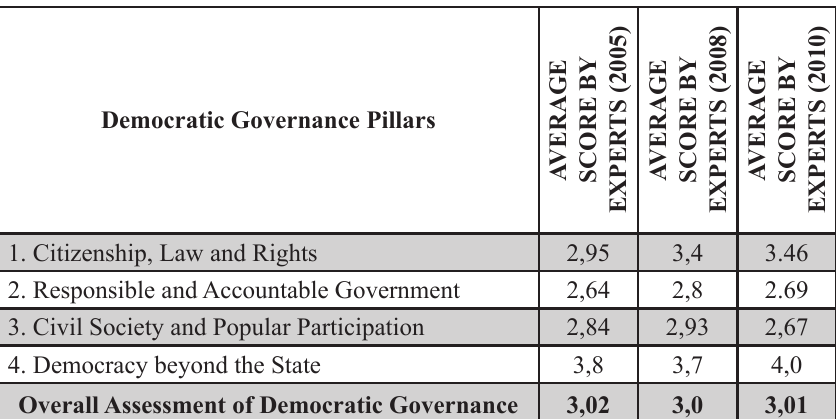
Table 13. Overall assessment of Democratic Governance in Mongolia